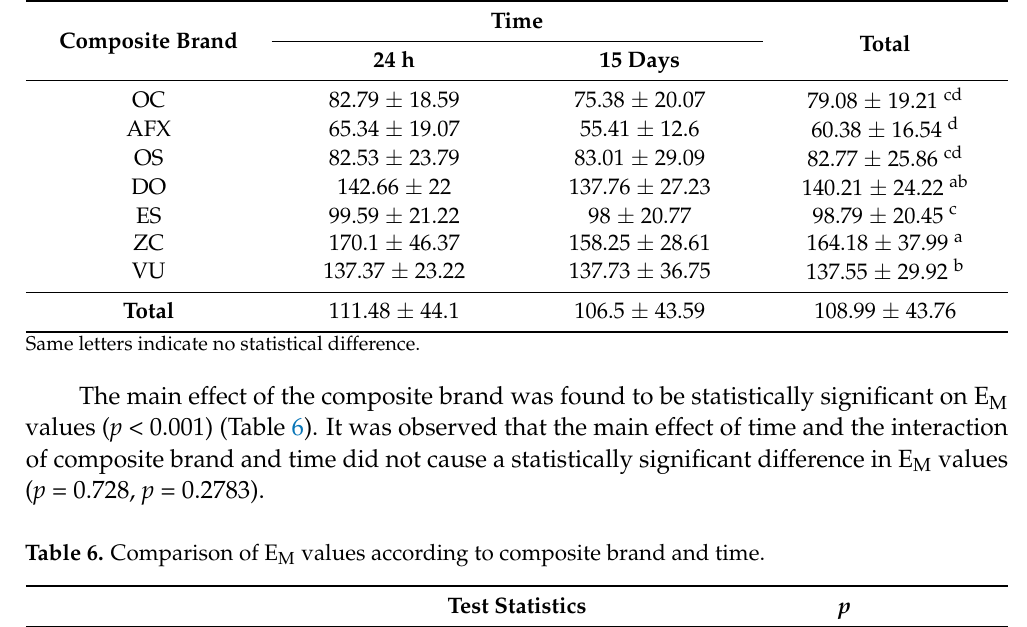
Table 5. Multiple comparison of F S (MPa) values of the tested composites according to time intervals.